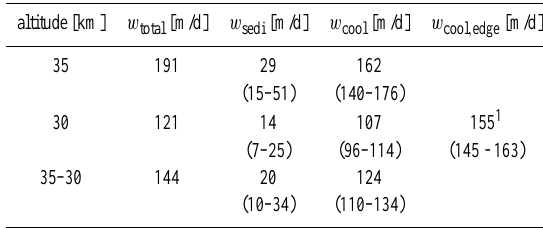
Table 4. Descending velocity of an aerosol layer in the middle stratosphere. Downward velocities are defined to be positive. Num- bers are for ρ = 3500kg / m 3 with results for soot and iron given in brackets (ρ = 2240kg / m 3 and ρ = 7900kg / m 3 , respectively). The sinking rate due to diabiatic cooling w cool is scaled by 0.75 (0.6 to 0.75) with respect to the data of Schoeberl et al.